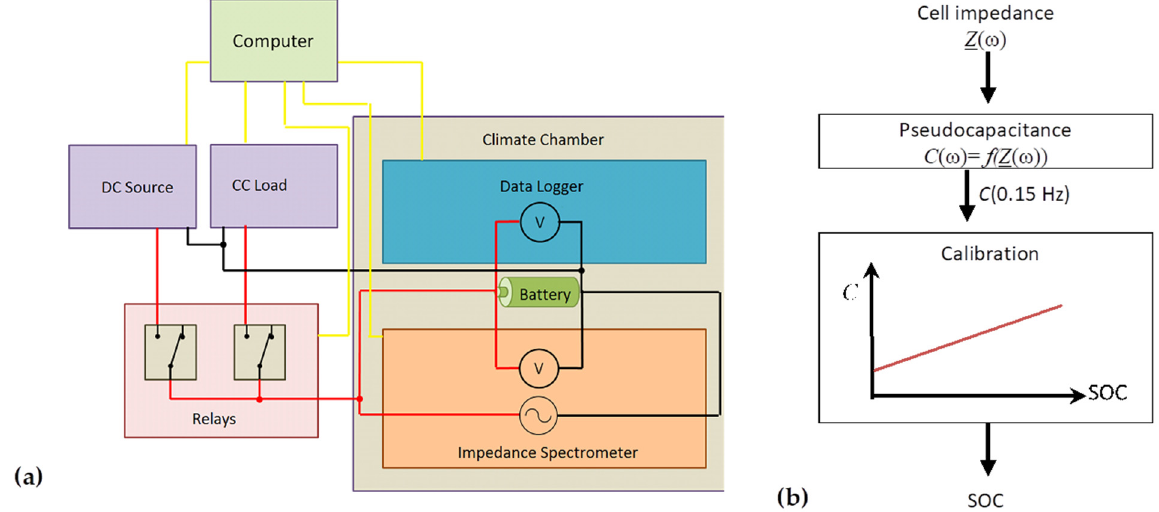
Figure 2. ( a ) Schematic measurement setup: Impedance spectrometer BIM2 (BRS GmbH, Stuttgart, Germany), data logger (Agilent 34972A), electronic load (ET Systems ELP/DCM 9712C), DC power source (Elektro-Automatik EA-PS 2342-10B), and relay box reside in a climatic chamber (Vötsch VT7021). Data acquisition: Labview. ( b ) Basic model assumption and data evaluation.